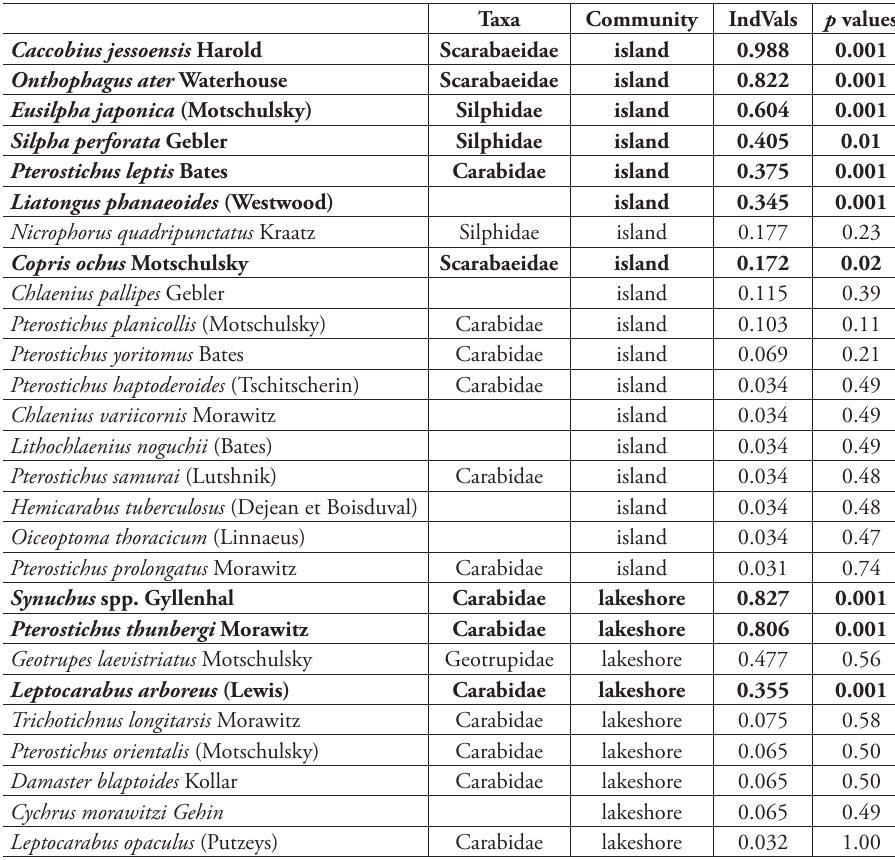
Table 4. The indicator species values of each species. Bold letters represent p <